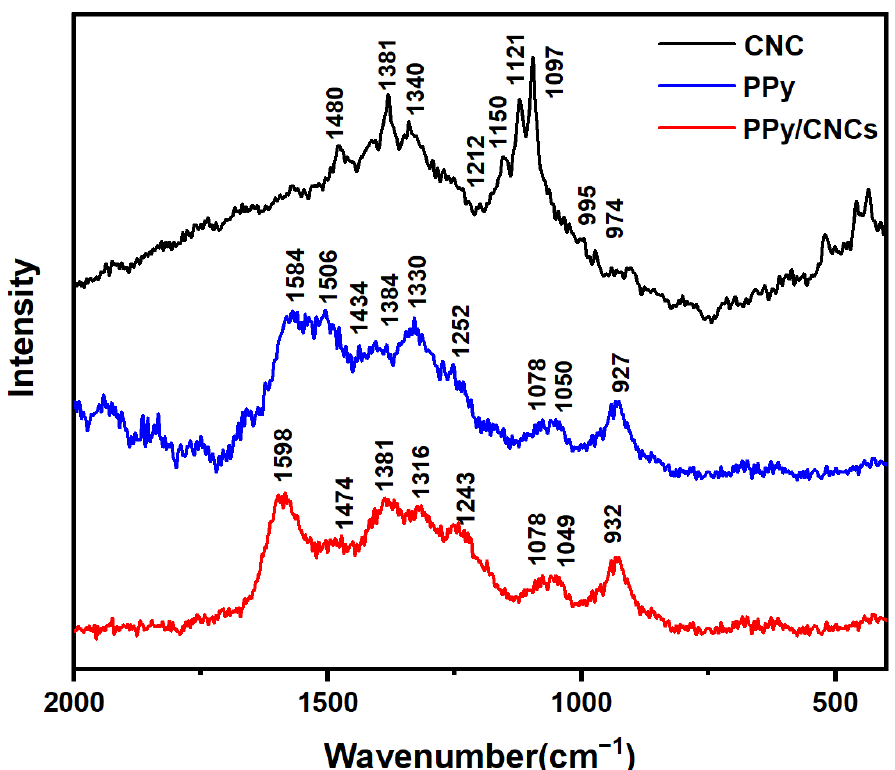
Figure 9. Raman spectra of CNC, PPy and PPy/CNCs .